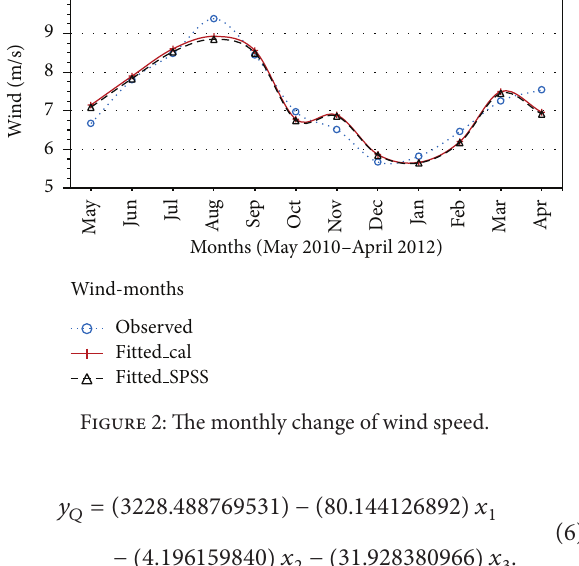
Figure 3: The monthly change of insolation